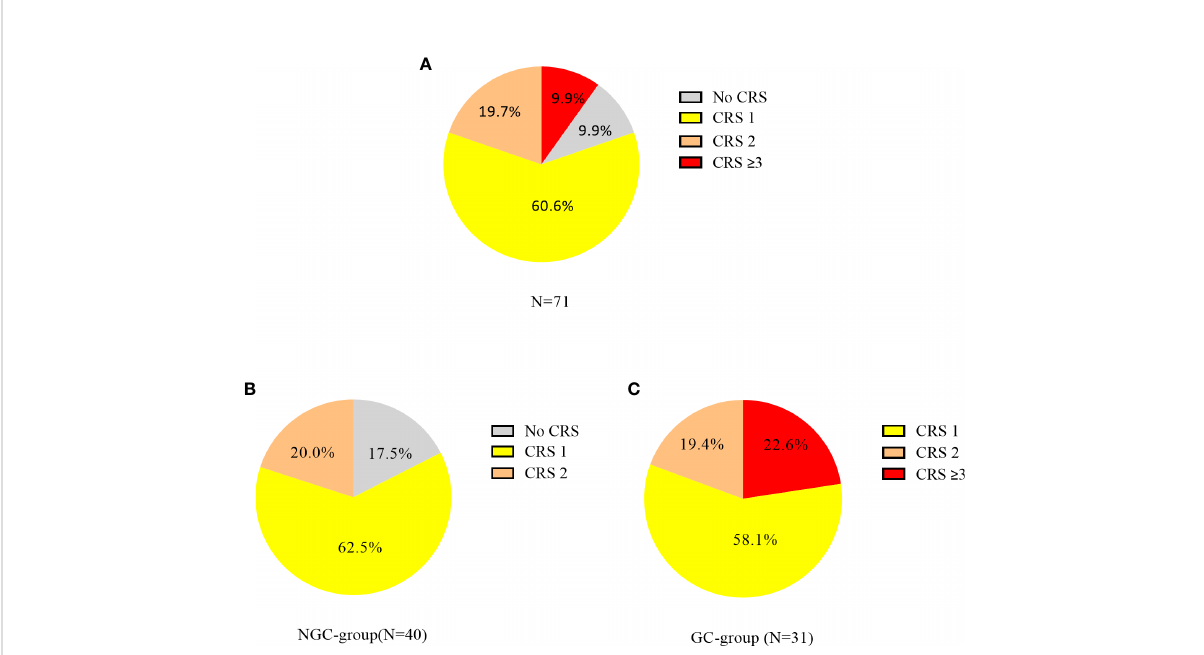
FIGURE 1 Cytokine release syndrome (CRS) incidence and severity in patients with CAR-T cell therapy. CRS was graded according to the ASTCT consensus grading system. (A) CRS incidence in all patients; (B) CRS incidence in the NGC group. (C) CRS incidence in the GC